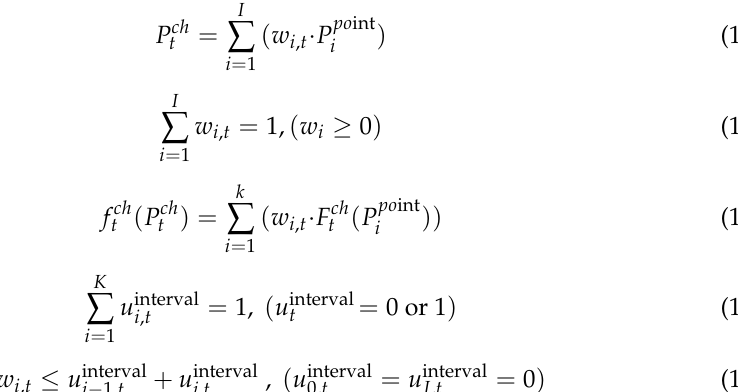
ch F , as in Equations (14)–(18). t